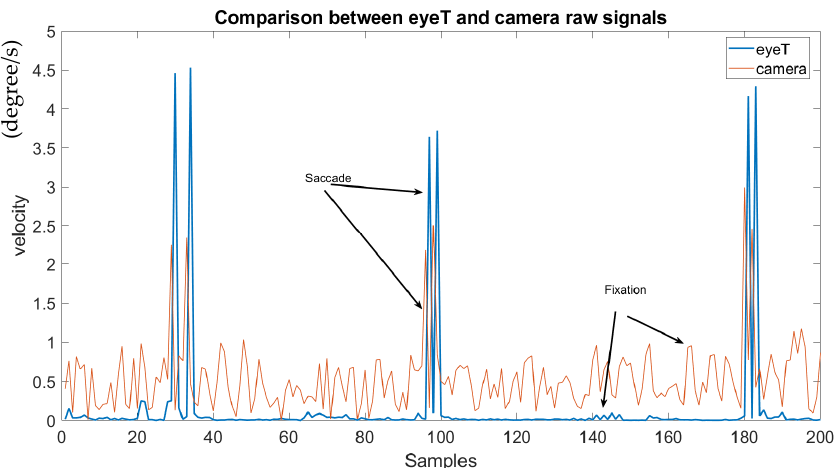
Figure 10. Visualization of the raw signals extracted by the camera system and compared with the eyeT system.